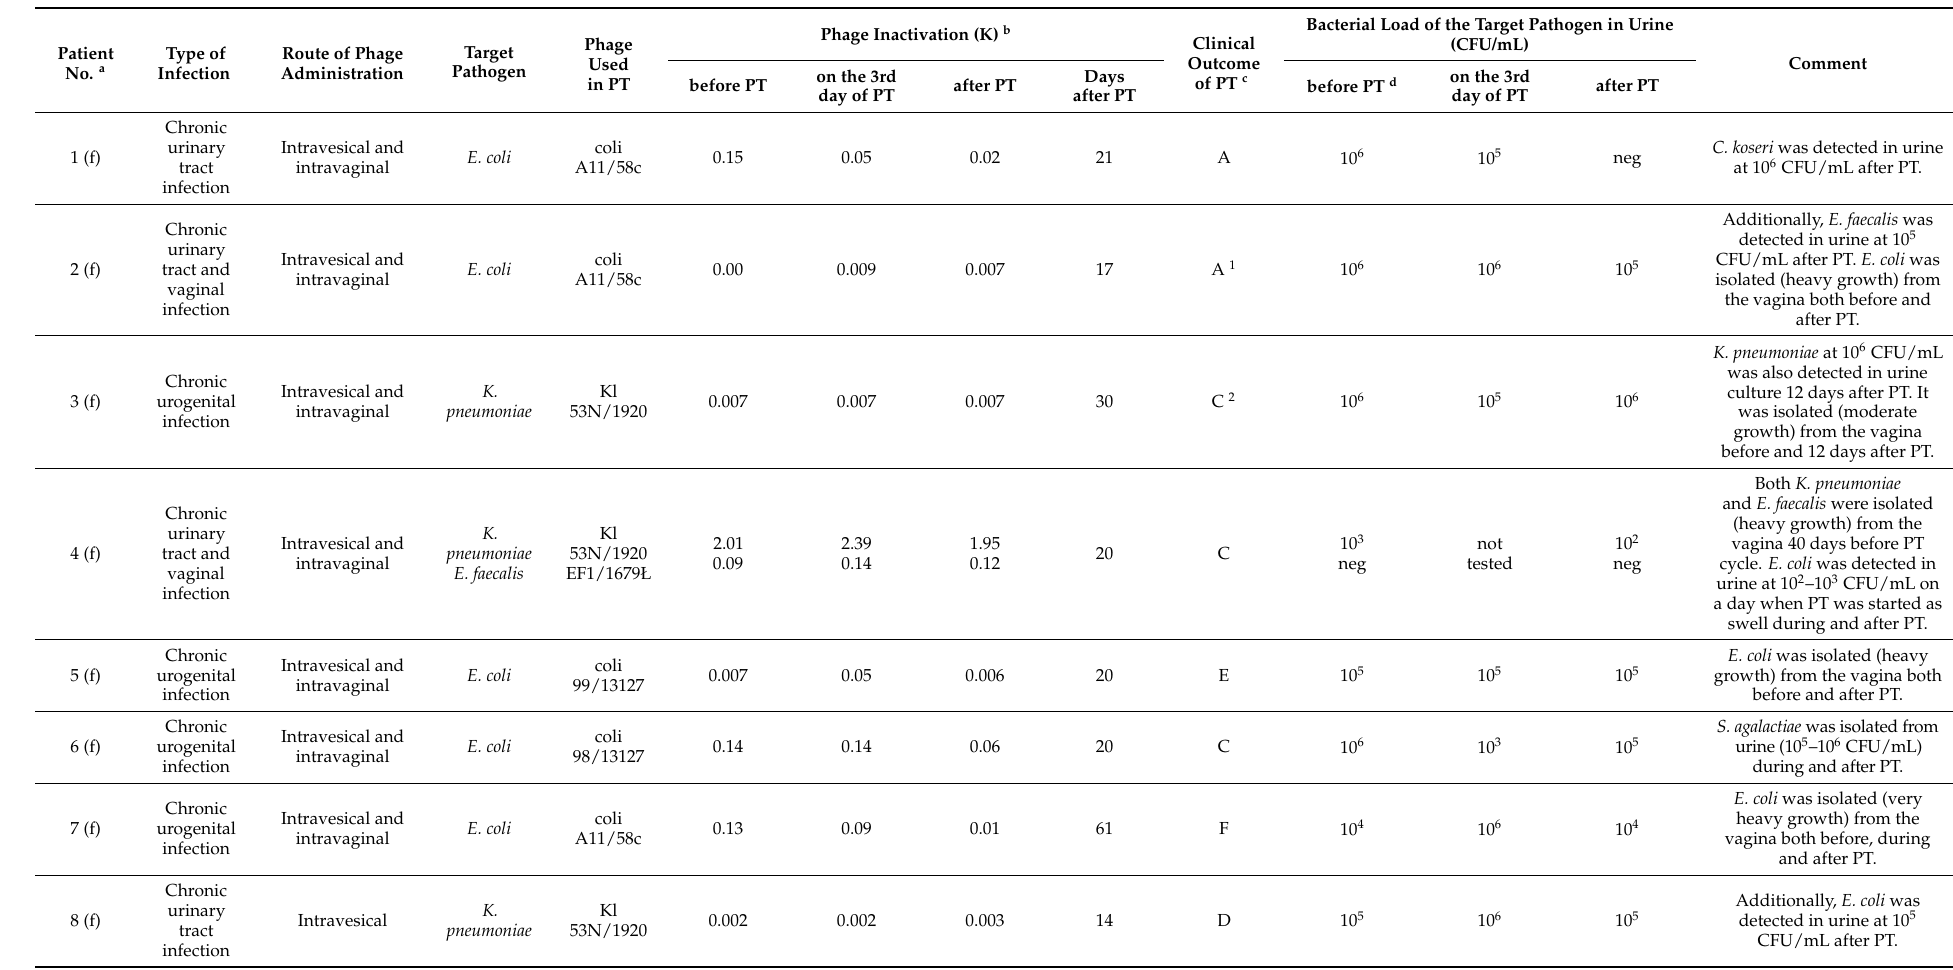
Table 1. Patients with chronic urinary or urogenital infections undergoing one cycle or the first cycle of phage